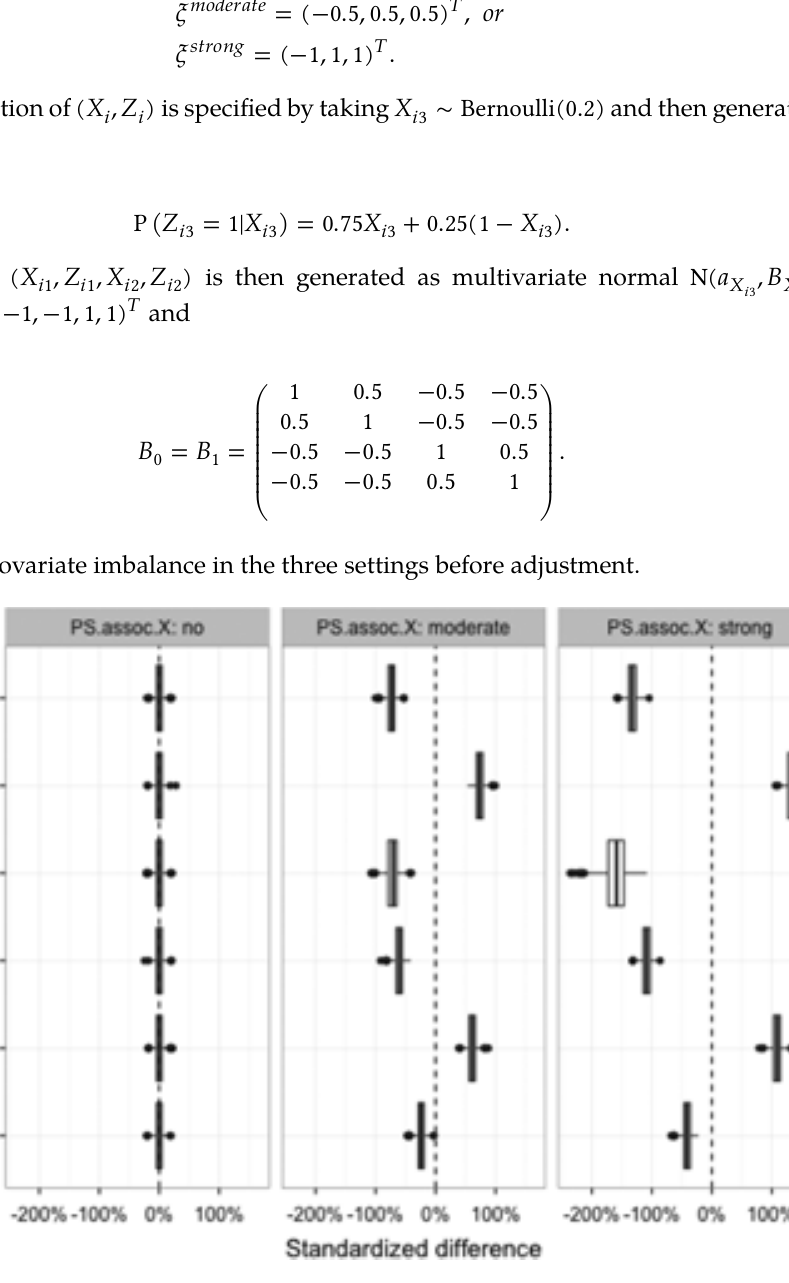
Figure 4: Lunceford-Davidian example: covariate imbalance before